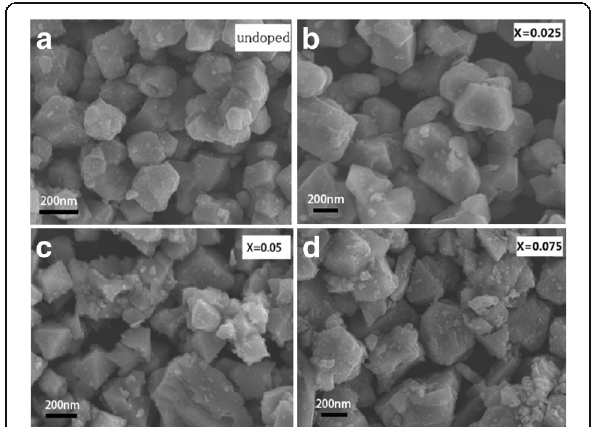
Fig. 2 SEM images of LiCr x Ni 0.5 − 0.5x Mn 1.5 − 0.5x O 3.95 F 0.05 .( a ) x = 0, ( b ) x = 0.025, ( c ) x = 0.05, ( d ) x =